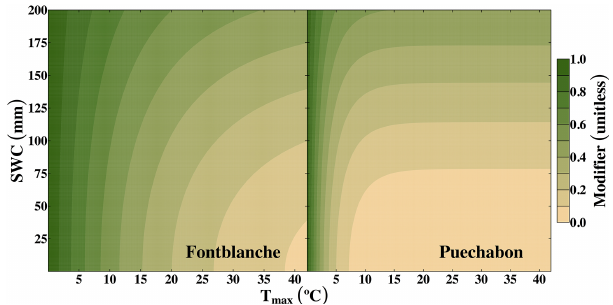
Figure 5. Modelled carbon allocation trajectory to the stem when leaf flush has finished in phenological period (P4). We show the unitless modifier 1 − h 4 (i) (i.e. h 4 (i) is the portion of carbon allo- cated to storage) from C stem (i) = A N (i) × [(1 − h 4 (i) )] in Eq. (11). The modifier [0,1] is a function of soil water content (SWC) and maximum temperature (Tmax); multiplied with available daily car- bon, it gives the distribution of daily carbon allocated to secondary growth and